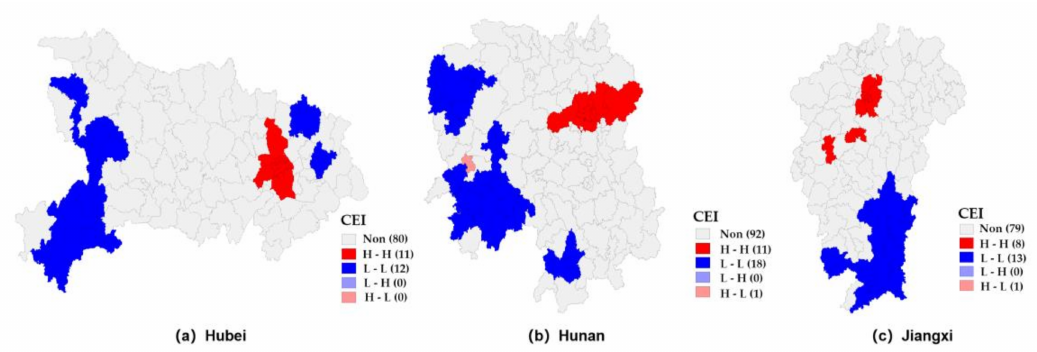
Figure 8. Local indicators of spatial association (LISA) of the CEI in Hubei, Hunan and